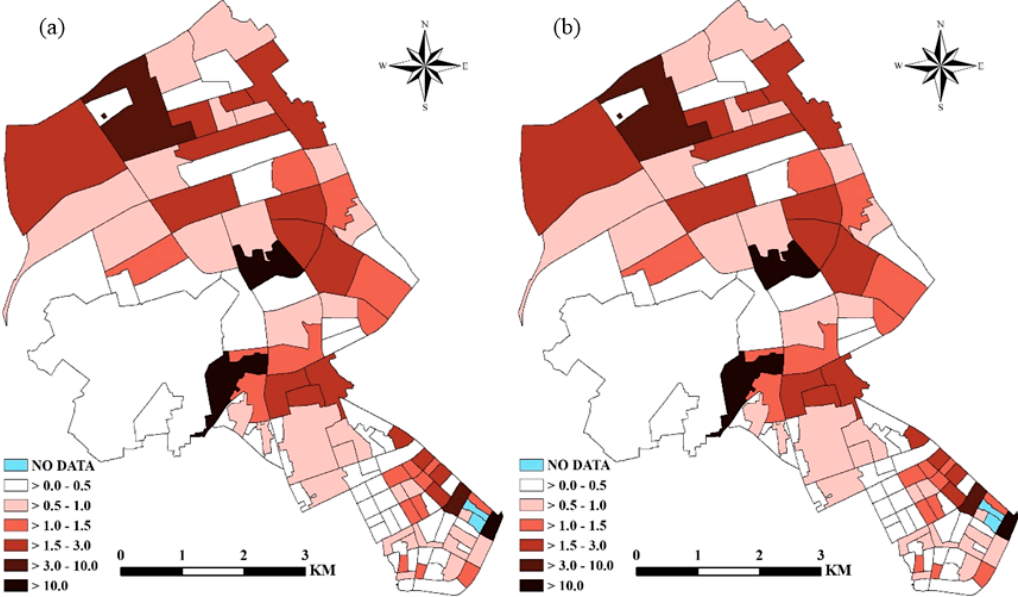
e ff ect Figure 2. Burglary risks given by ( a ) the conventional Bayesian spatial model and ( b ) the contextual effect model.